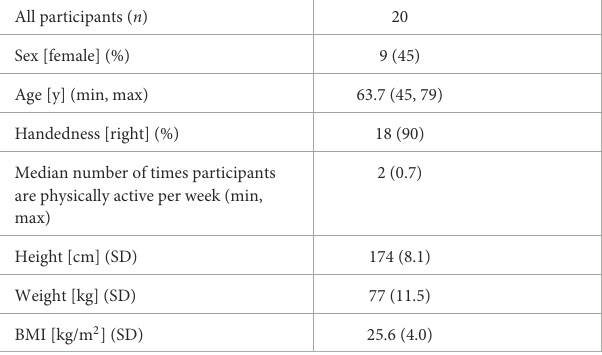
Normality of the residuals was assessed using QQ-plots, and a Shapiro-Wilk test was performed using the R rstatix package (11).